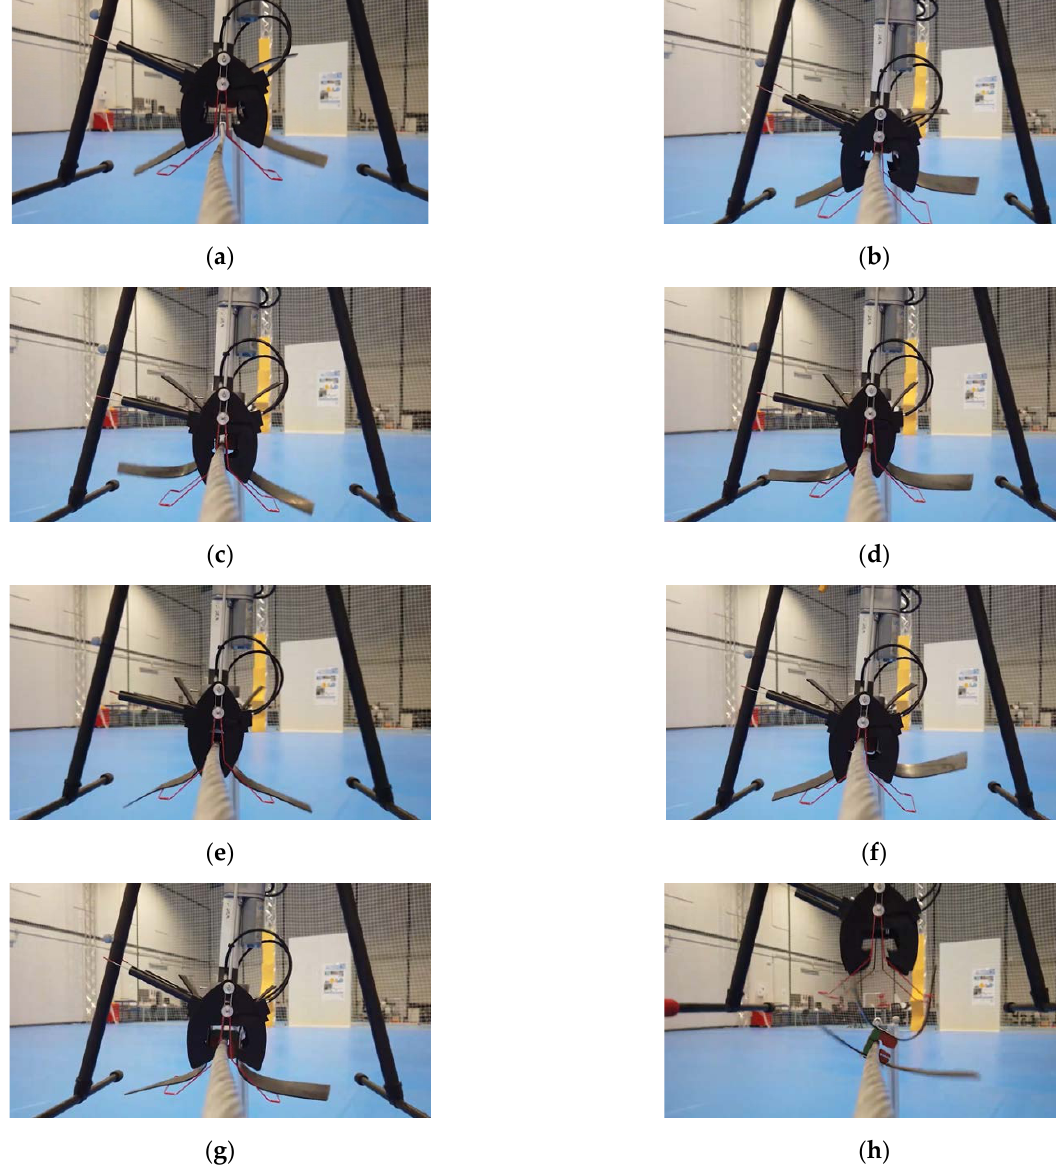
Figure 16. A series of images to show the sequence of the process; ( a ) approaching, ( b ) positioning the device, ( c ) pushing down the diverter, ( d ) fixing the diverter, ( e ) clamping, ( f ) opening, ( g ) retreating of the linear actuator, ( h ) fly back to station.